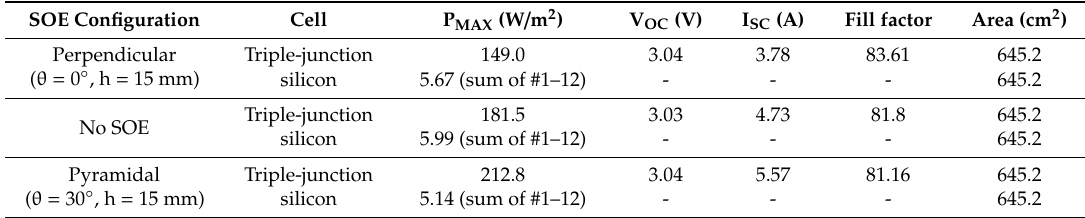
Figure 6. Photographs of experimental measurement setup: ( a ) the solar simulator (WACOM, WXS-450S-65), ( b ) the CPV module with a Fresnel lens and a heat sink, ( c ) the perpendicular SOE ( θ = 0°, h = 15 mm), ( d ) the pyramidal secondary optical element (SOE) ( θ = 30°, h = 15 mm), ( e ) the laminated triple-junction solar cell with bypass diode, and ( f ) the polycrystalline silicon solar cell. Also shown are I-V and P-V curves of the ( g ) triple-junction solar cell and ( h ) silicon solar cells for the three SOE configurations. Table 3. Device characteristics of the triple-junction and 12 silicon solar cells of the hybrid CPV module, using three SOE configurations.